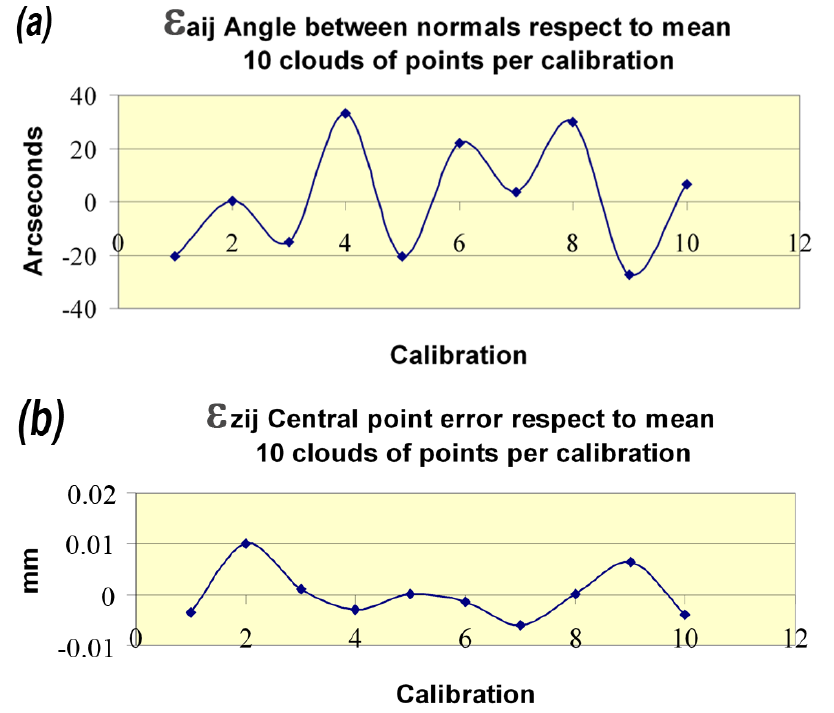
Figure 12. Calibration influence on system repeatability: (a) Angle between normals mean repeatability. (b) Projected central point error mean repeatability.